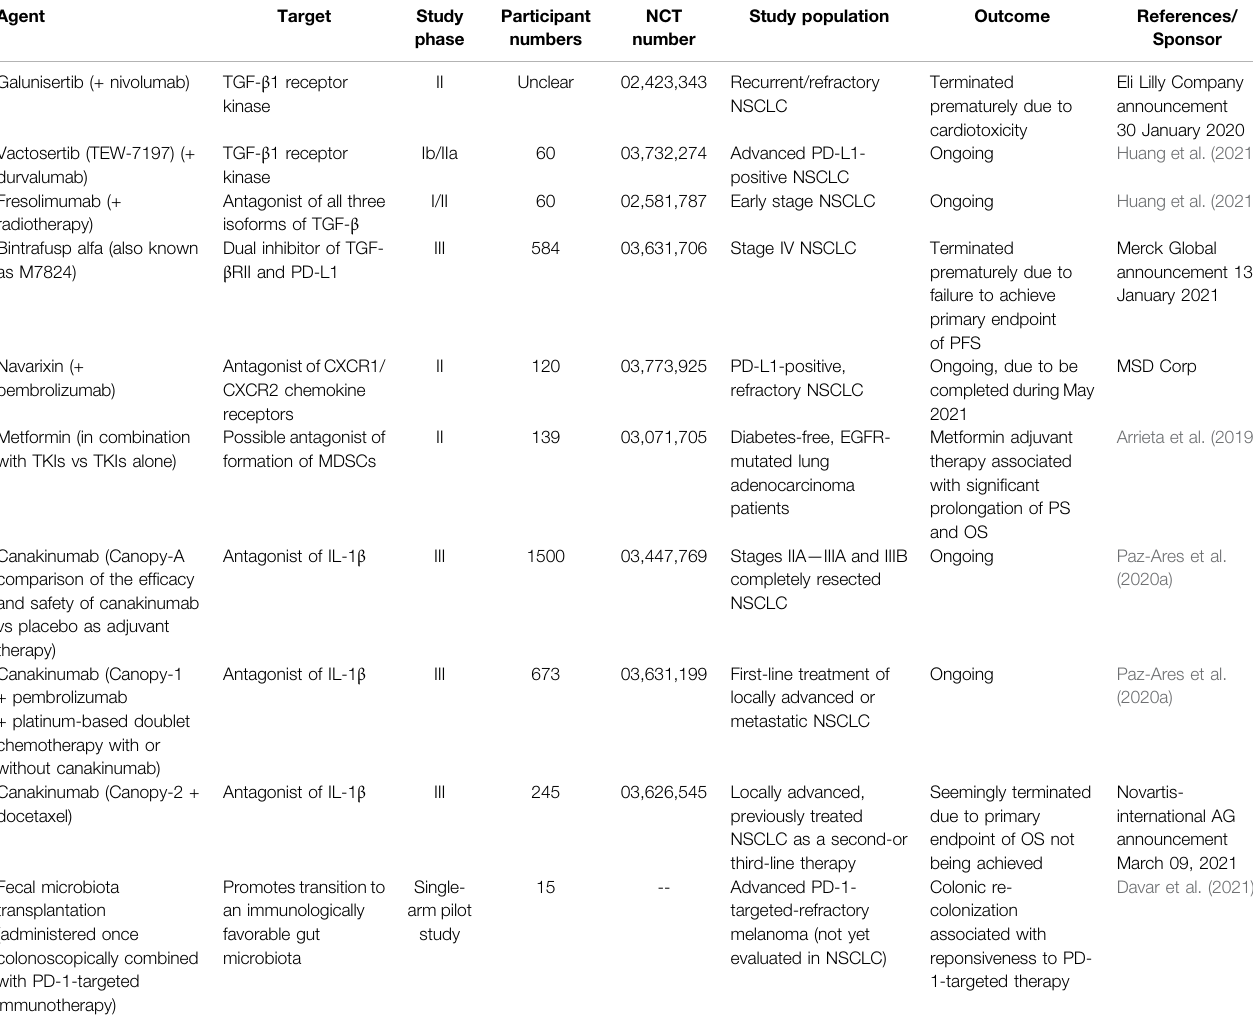
TABLE 2 | Summary of clinical trials in NSCLC with putative inhibitors of neutrophil/MDSC activity.